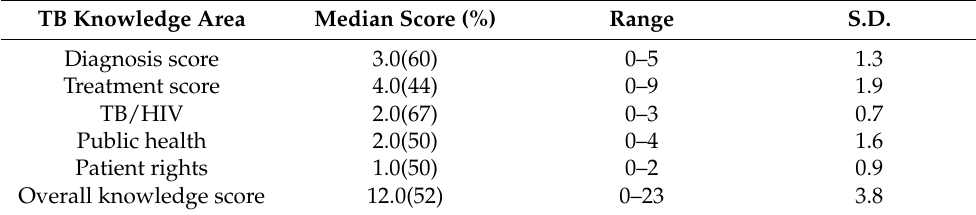
Table 3. Aggregate knowledge score of participants on tuberculosis standards of